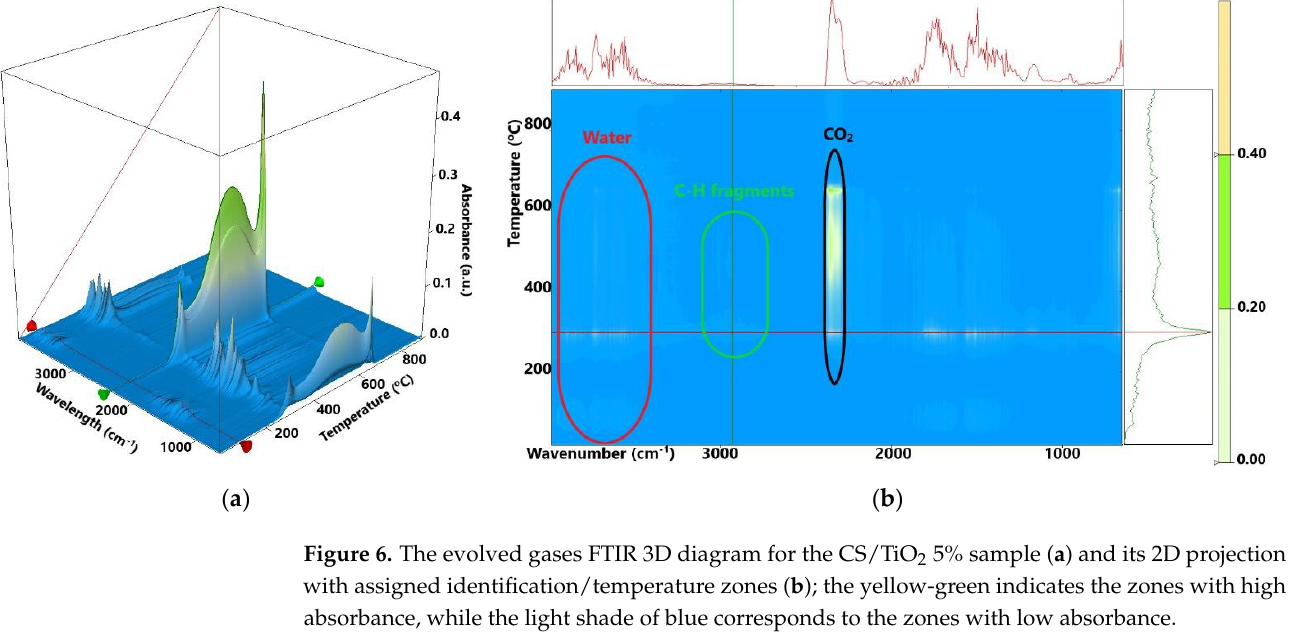
Figure 5. TG-DSC curves of chitosan and chitosan/TiO 2 composite membranes.